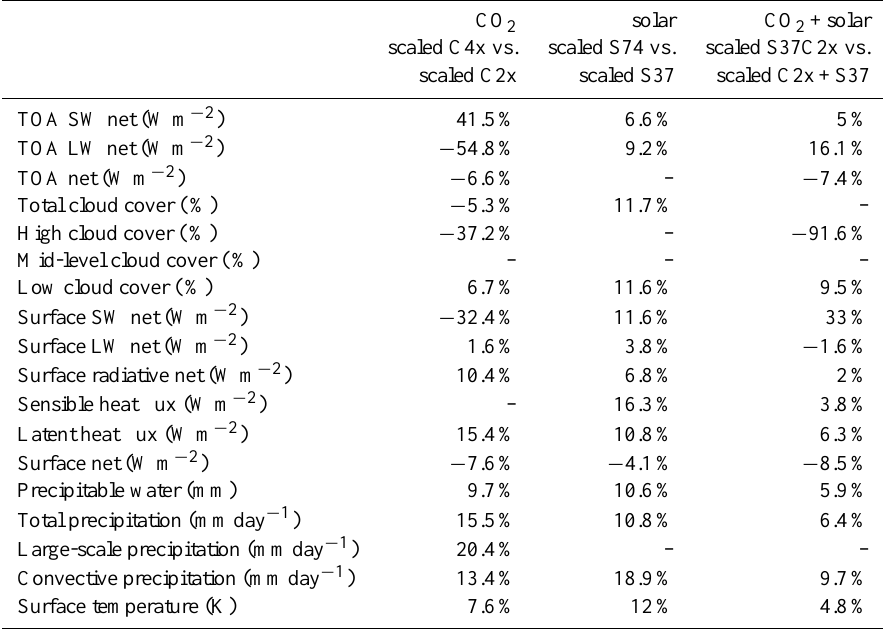
Table 1. Results from the linear additivity test on chosen variables of the energy budget and hydrological cycle scaled by the adjusted forcing in the scenario. Positive values indicate that the high forcing scenario has a larger response than expected doubling/addition of the low forcing scenarios. Only statistically significant differences are shown, the linear additivity assumption is valid where no value is